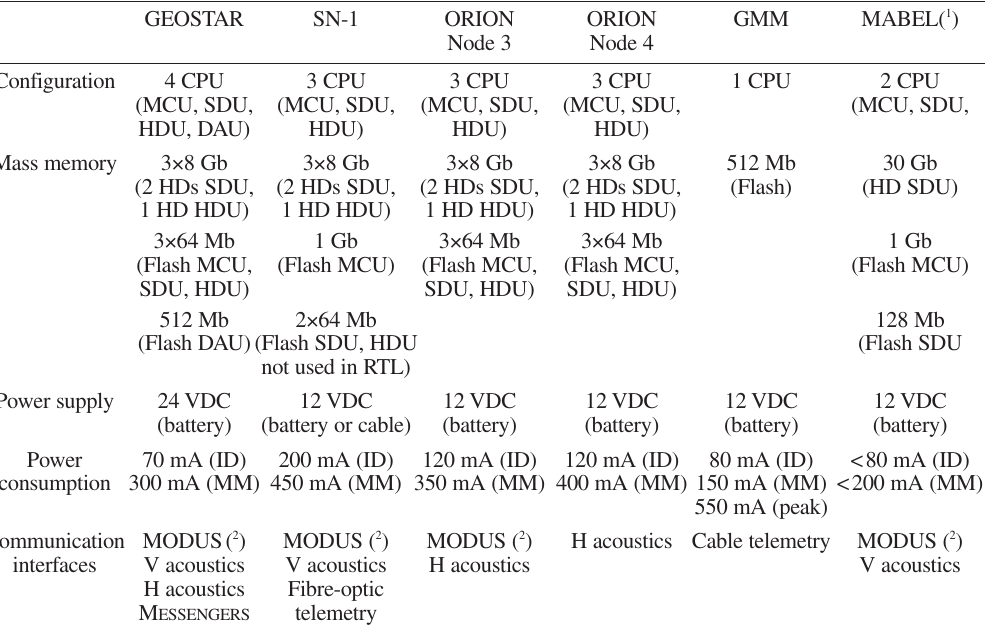
Table II. DACS main technical characteristics of the GEOSTAR-class platforms ( e.g. , Gasparoni et al. ,